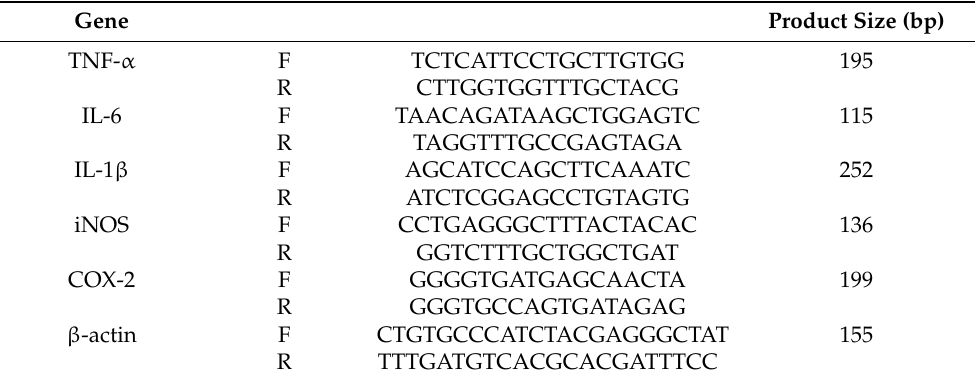
Table 1. Primer sequences of RT-PCR